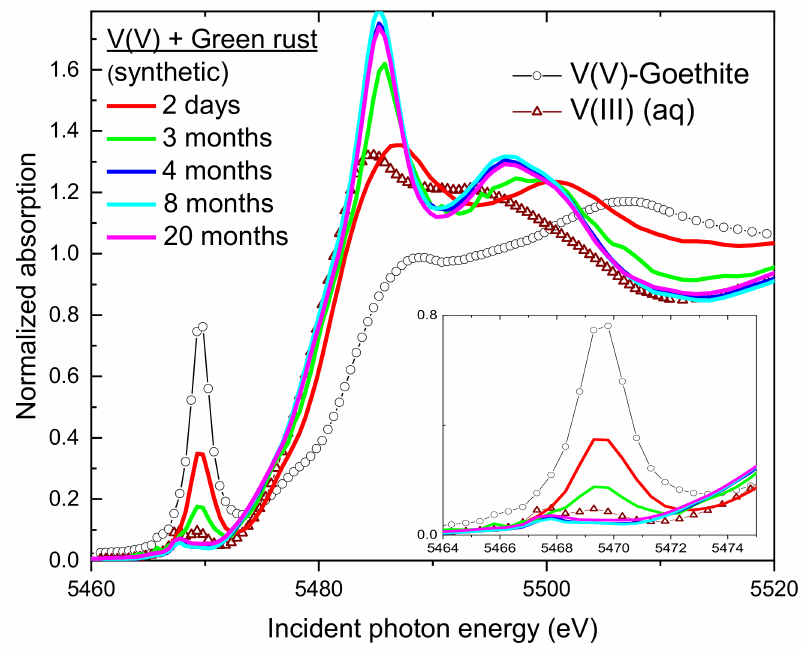
Figure 7. The V K-edge XANES spectra of the solids in the green rust system over time compared to representative standards V(V) sorbed to goethite and aqueous V(III). Inset shows details in the pre-edge